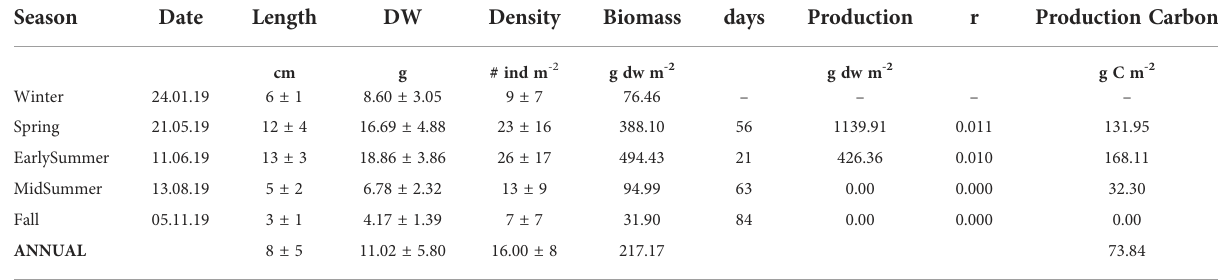
TABLE 1 Seasonal and annual production estimation of biomass (g dw/m 2 ) and carbon (g C/m 2 ) and daily biomass turnover (r) estimated by the formula by Cebrian and Ballesteros